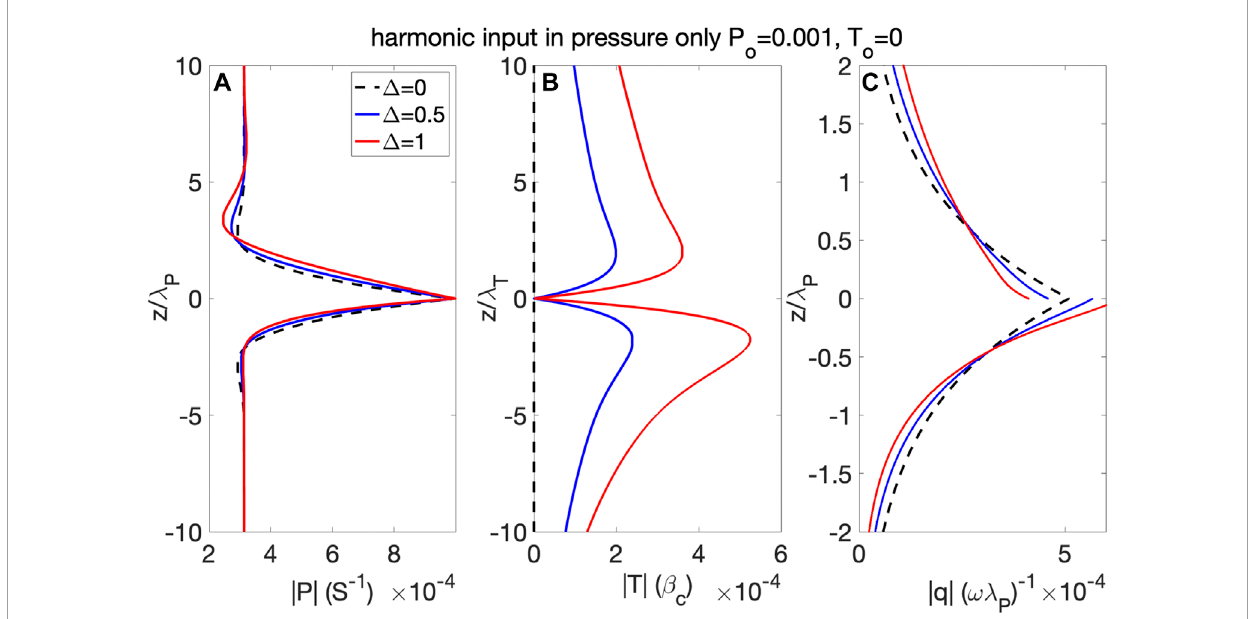
FIGURE 5 Examples of pressure, temperature and velocity oscillation amplitudes ̂ P ( z ) , ̂ T ( z ) , and ̂ q ( z ) as functions of vertical distance z for a system with De = ∞, R = 100 shown for cases with different Δ . The perturbations are triggered at z = 0 by a harmonic oscillation in pressure. Oscillations in the upper domain ( z > 0 ) result from bottom-up propagation; oscillations in the lower z < 0 domain result from top-down propagation. Black dash lines correspond to the end-member case with no thermal gradient Δ = 0 where amplitudes for top-down and bottom-up propagations are symmetric